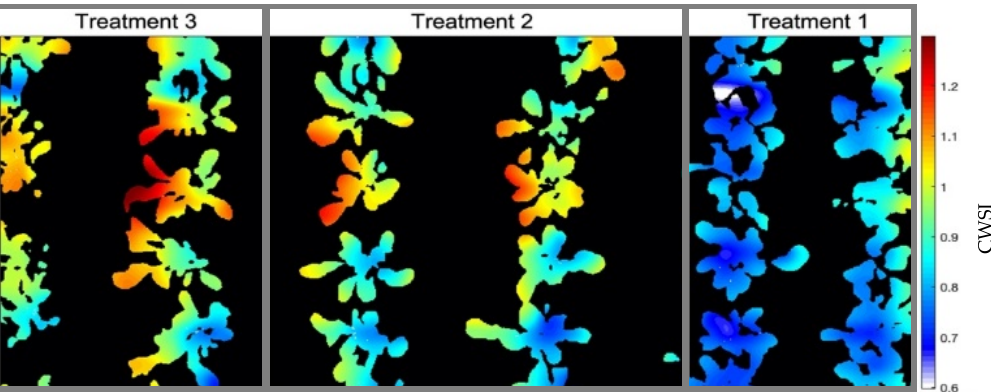
Figure 14. CWSI (Crop Water Stress Index) map of the experimental area in an unprotected environment generated for 25DAP (Day After Planting). The upper and lower limits of NWSB D did not indicate actual temperature values, and the minimum calculated CWSI was 0.6, corresponding to the situation without water stress. Treatment 1 (T 1 = 85% FC (Field Capacity)); Treatment 2 (T 2 = 75% FC); Treatment 3 (T 3 = 55% FC).